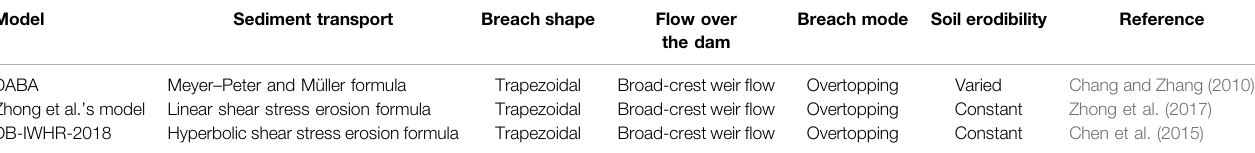
TABLE 5 | Several dam-break models based on dynamics proposed in recent